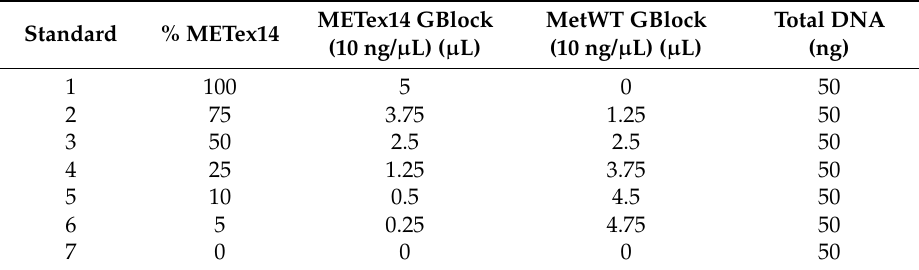
Table 2. GBlock dilution for assay sensitivity